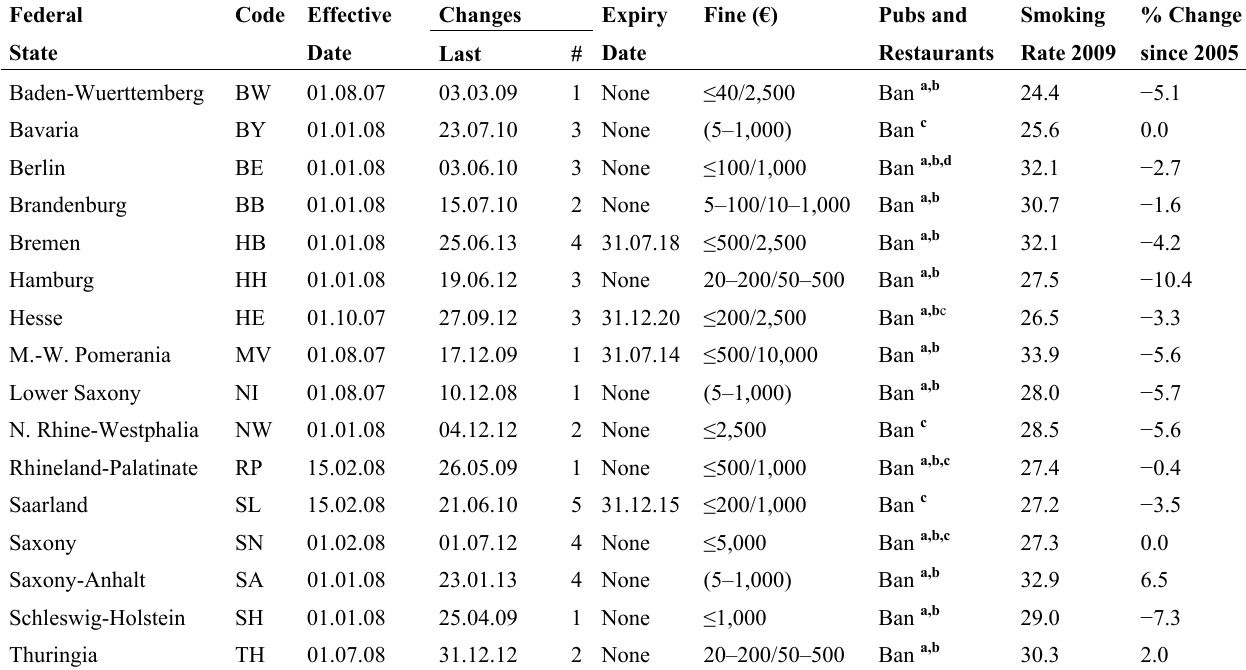
Table 1. Smoke-free laws, smoking bans and exemptions for pubs and restaurants, and smoking rates in the federal states of